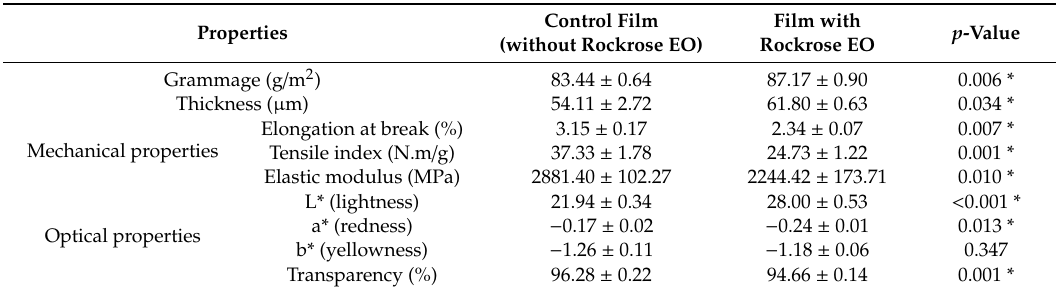
Table 5. Grammage, thickness, mechanical and optical properties of the